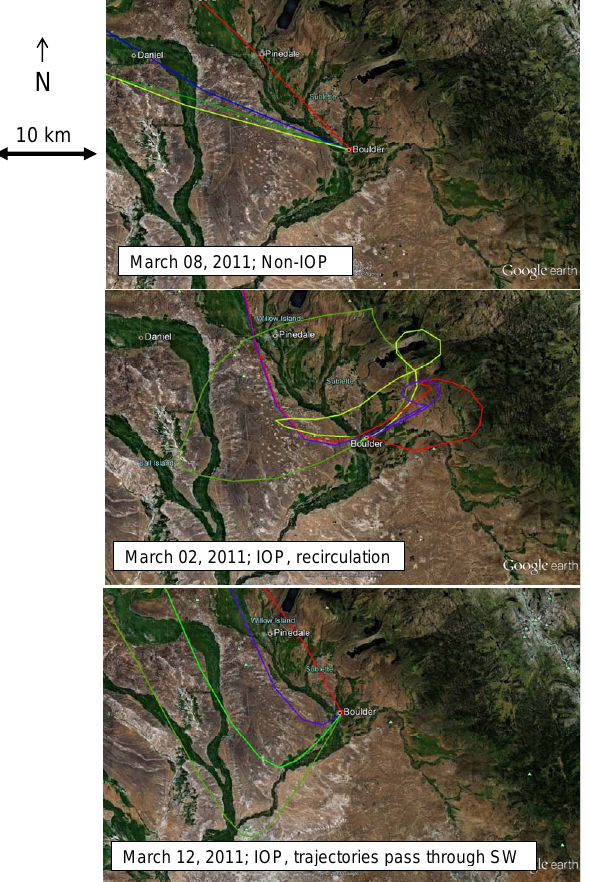
Figure 4. HYSPLIT backward trajectories calculated for 50 m a.g.l. and for the following arrival times at Boulder: 07:00MST (red), 12:00MST (blue), 14:00MST (light green), and 17:00MST (dark